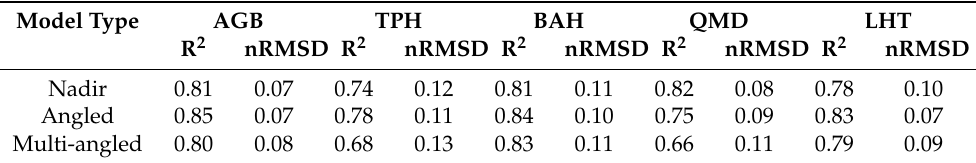
Table 5. Comparisons of plot-level forest metric predictions made by lidar to those of UAS